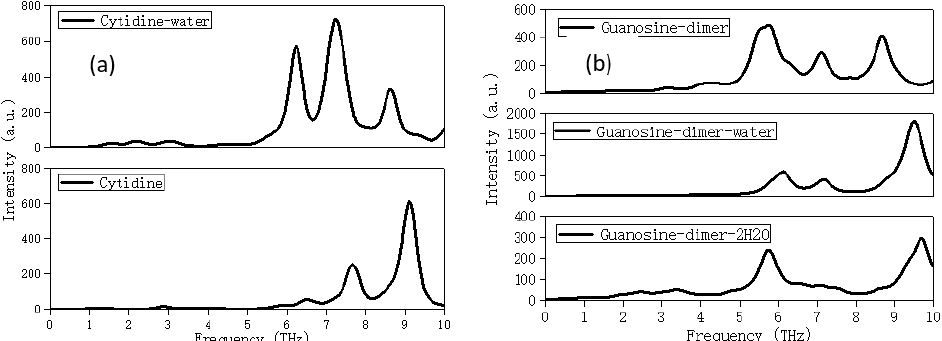
Figure 8. ( a ) The calculated spectra of cytidine single molecule using harmonic oscillator models, the initial structure in the implicit water solvent and gas phase, respectively. ( b ) The calculated spectra of guanosine dimer in the gas phase, with implicit and explicit solvent, respectively.